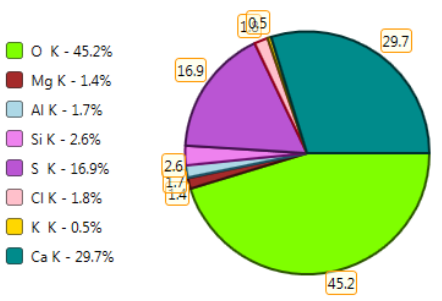
Figure 19. X-ray microanalysis (EDS) in point 1 from Figure 18.